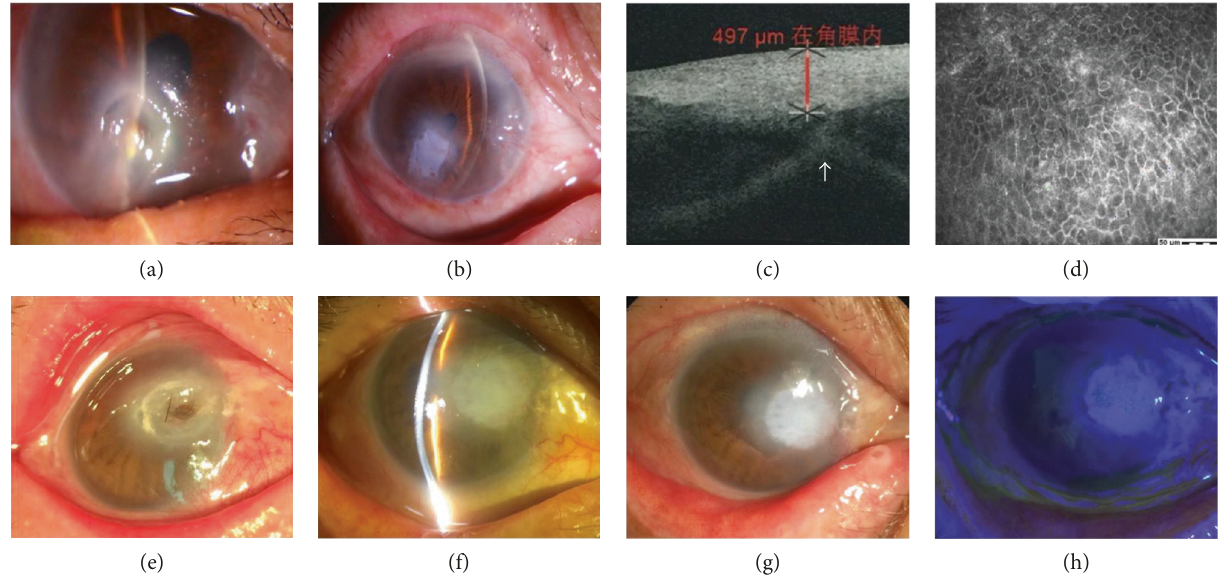
Figure 3: Reconstruction of perforated HSK. Case number 4. A 75-year-old female patient presented with a nonhealing corneal ulcer in her right eye caused by HSK. A deep corneal ulcer with a small perforation was noticed (a). One month after UCP transplantation, the anterior chamber formed (b) although a slight anterior synechiae of the iris was detected by OCT (c, arrow). The stromal thickness at the perforation site seemed normal (c). The UCP was completely epithelialized (d). Case number 6. A 70-year-old man had a 2 × 2mm perforated corneal ulcer (e) secondary to HSK. One month after UCP graft, the cornea was successfully reconstructed with a well-formed anterior chamber (f). The cornea stayed stable (g) with a negative fl uorescent staining (h) at the eighth-month